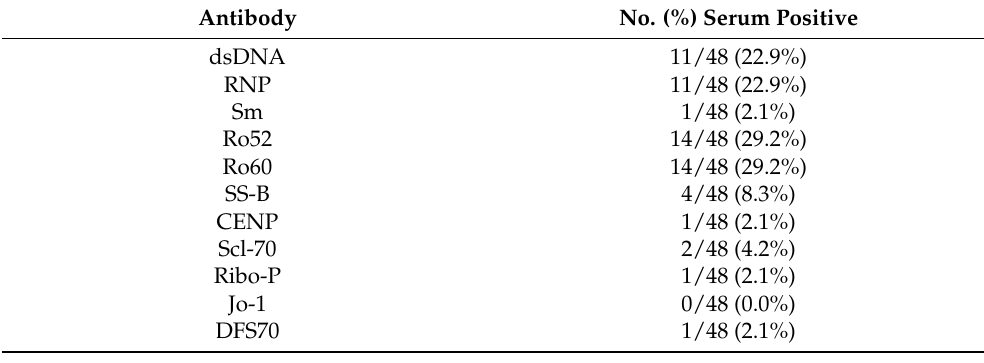
Table 3. Prevalence of autoantibodies in the patient cohort.